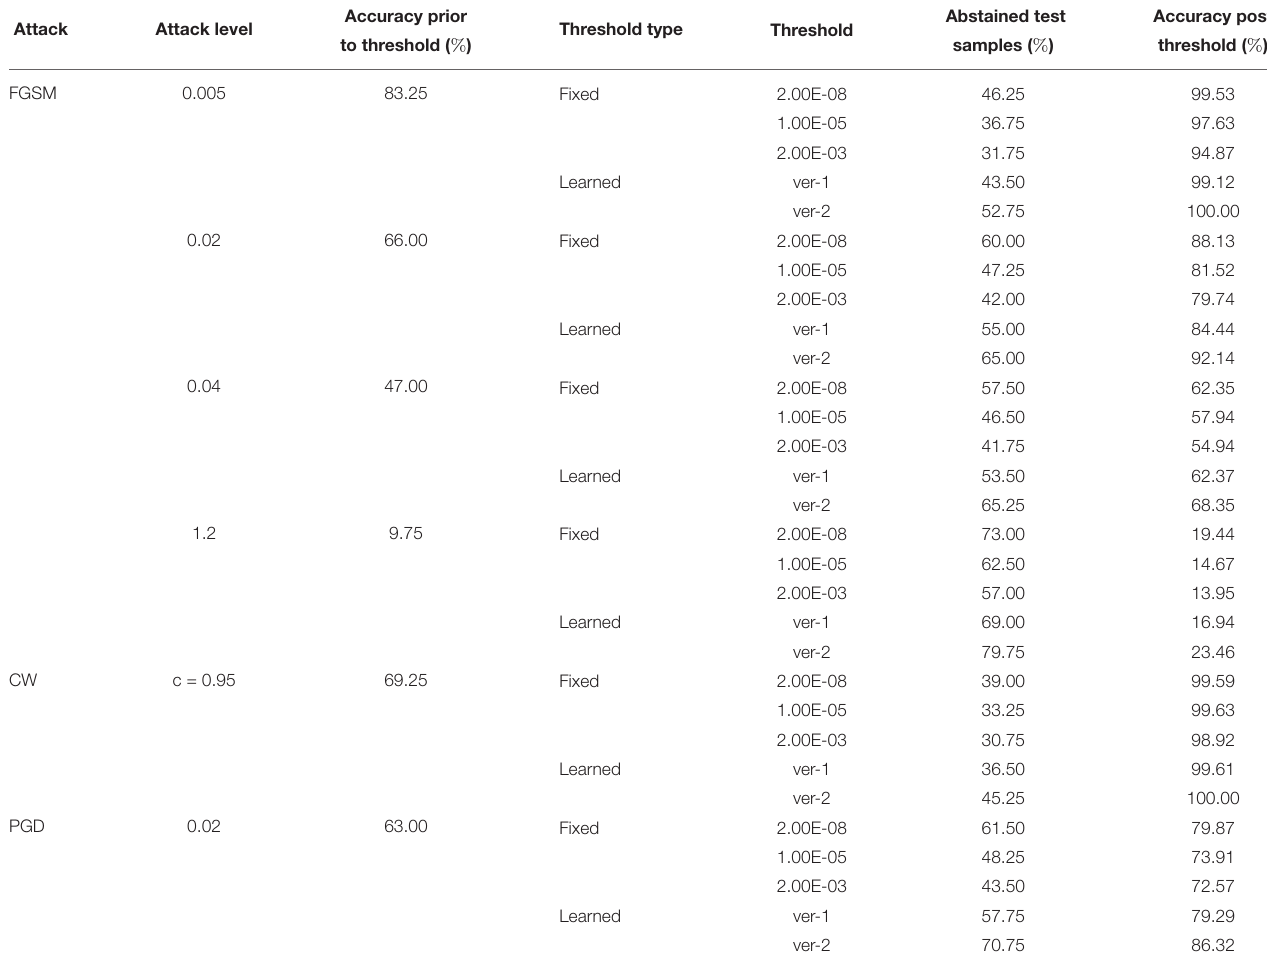
TABLE 10 | Detection of failure in BDNNs—OrganAMNIST dataset tested under various types of adversarial attacks.